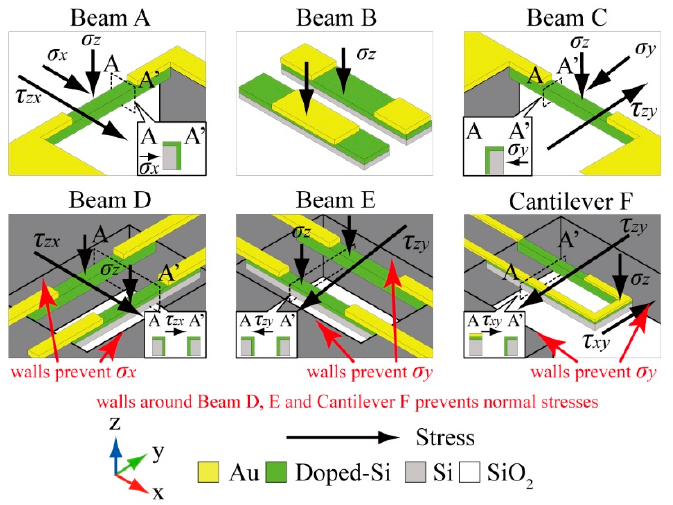
Figure 2. Schematic images of each sensing elements.